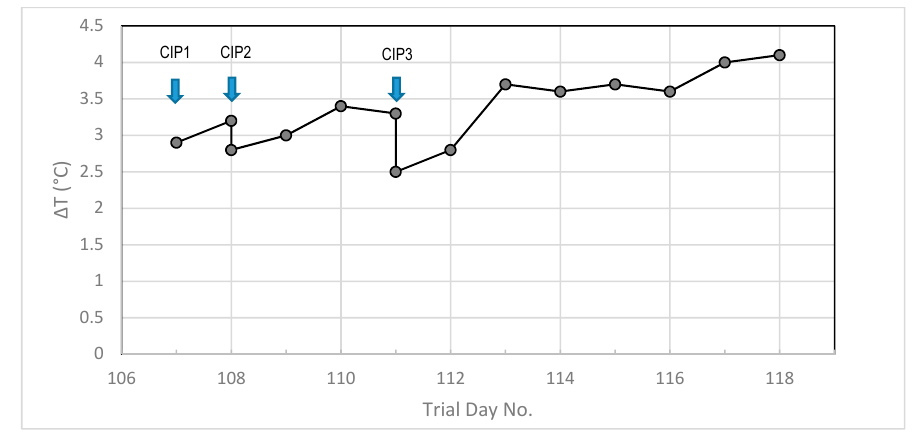
Figure 6. Effect of different CIP procedures on Δ T during continuous pilot plant operation, CP1 (low Figure 6. E ff ect of di ff erent CIP procedures on ∆ T during continuous pilot plant operation, CP1 (low strength caustic) on Day 107, CP2 (high strength caustic) on Day 108, CP3 (citric acid) on Day 111.